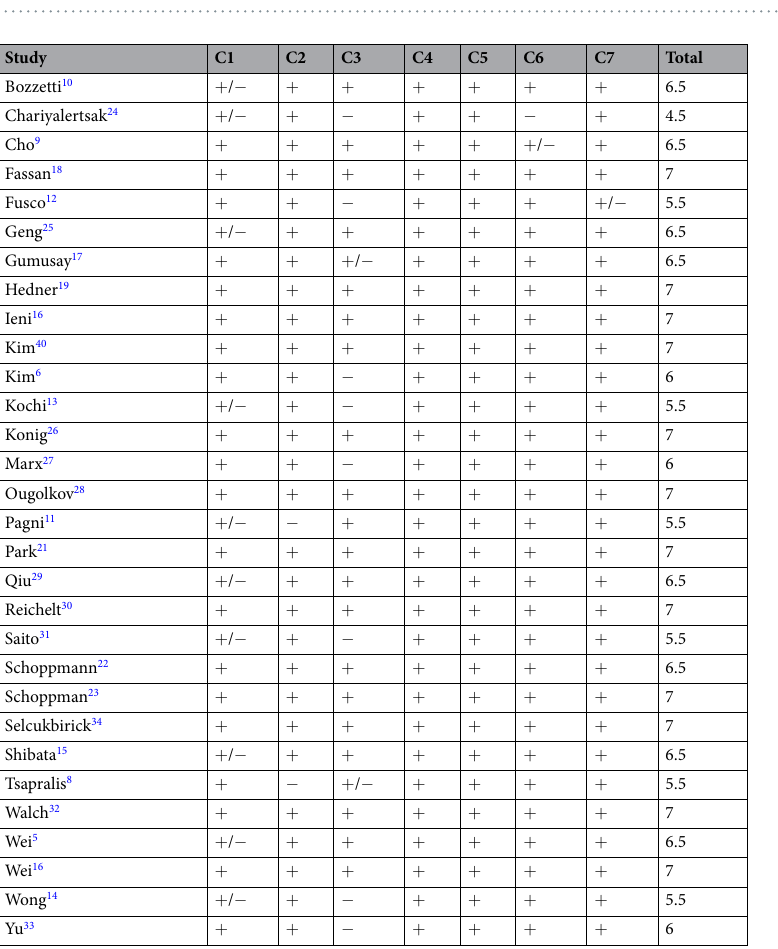
Table 2. Quality assessment according to adapted REMARK criteria. Studies are appointed one point for each item, half a point is allocated in case of ambiguity. Maximum score of 7